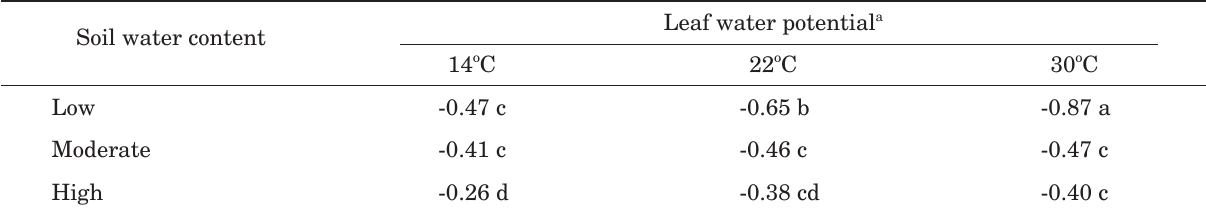
Table 1. Leaf water potential (pressure in MPa) of all grapevines ( Vitis vinifera cv. Red Grenache), inoculated and control treatments combined, subjected to nine combinations of soil water content and air temperature for 11 weeks in a shadehouse in South Australia on 4 December 2008 using a pressure chamber. Nine replications per